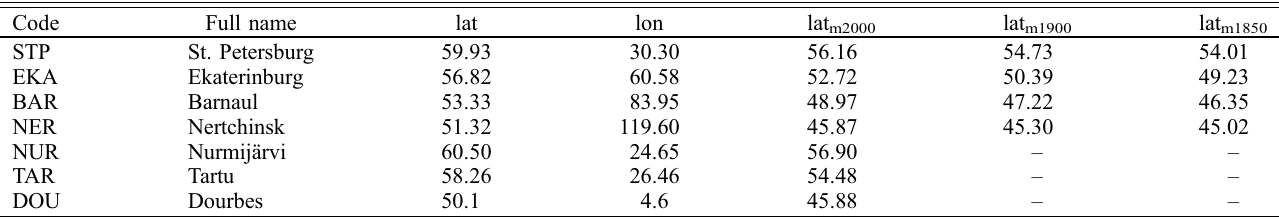
Table 1. Coordinates of the observatories used in this study. Corrected geomagnetic coordinates (CGM) are given for the years 2000 and 1900 a . The last column gives the linearly extrapolated value for 1850. For Nurmija¨rvi, Tartu and Dourbes, the CGM coordinates in 1850 and 1900 are